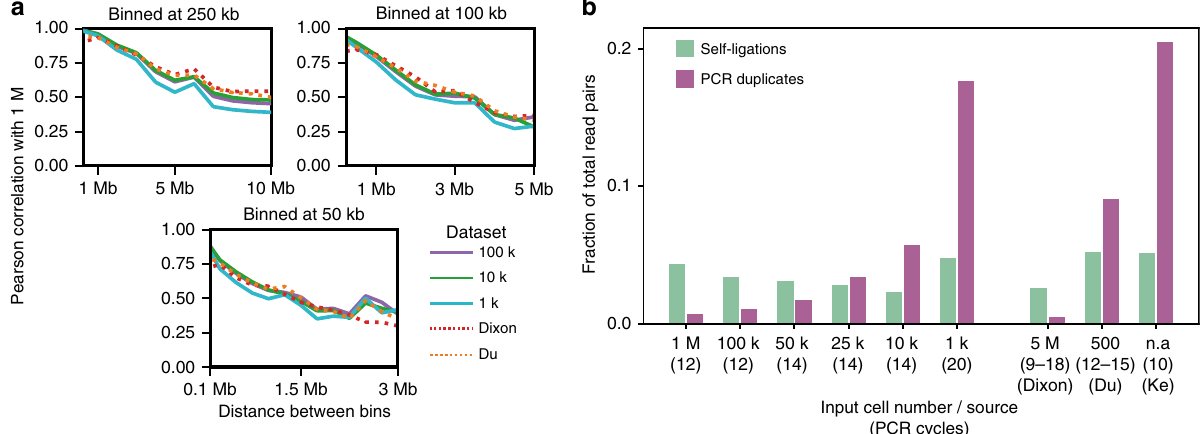
Fig. 2 Analysis of experimental biases and quantitative properties of Low-C libraries. a Pearson correlation coef fi cient for contact intensities in bin pairs at increasing distances from the diagonal. Each plot represents different bin sizes, indicated above the plot. Colours correspond to input cell number or sample source, respectively. All reported correlations are with the 1 M sample. b Fraction of fragment pairs affected by and fi ltered out due to self-ligated fragments or PCR duplicates. Input cell numbers and PCR cycles (brackets) are indicated on the bottom of the plot. Note that all samples are in mESC, except for the Ke et al. 13 sample on the right, which is in zygote (PN5)